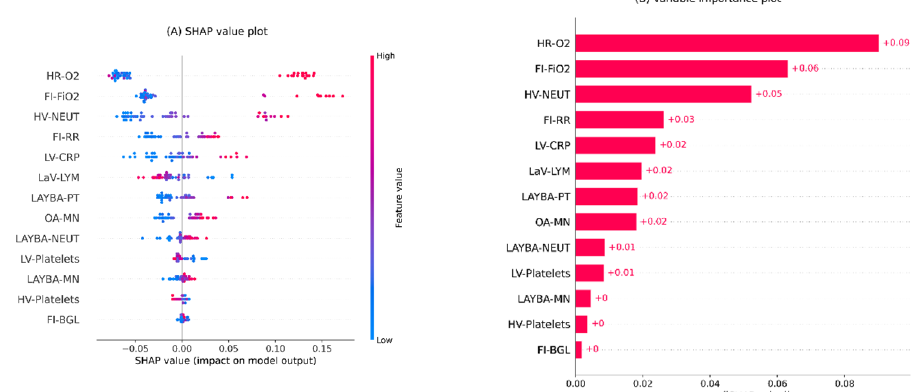
Figure 2. Global interpretation plots for the developed inpatient COVID-19 mortality prediction model. ( A ) Bee swarm SHAP values plot, ( B ) SHAP summary importance plot. The bee swarm plot shows all SHAP values in accord with predictors values. The summary plot presents predictors in descending order based on their overall importance on the model’s outcomes derived from mean absolute SHAP values. Note. BGL: blood glucose level; CRP: c ‐ reactive protein; FI: first inpatient; FiO2: fraction of inspired oxygen; HR: highest requirement; HV: highest value; LaV: last value; LAYBA: latest available within one year before admission; LV: lowest value; LYM: lymphocytes; MN: monocytes; NEUT: neutrophils; OA: on admission; O2: oxygen; PT: prothrombin time; RR: respiratory rate; SHAP: SHapley Additive exPlanations.